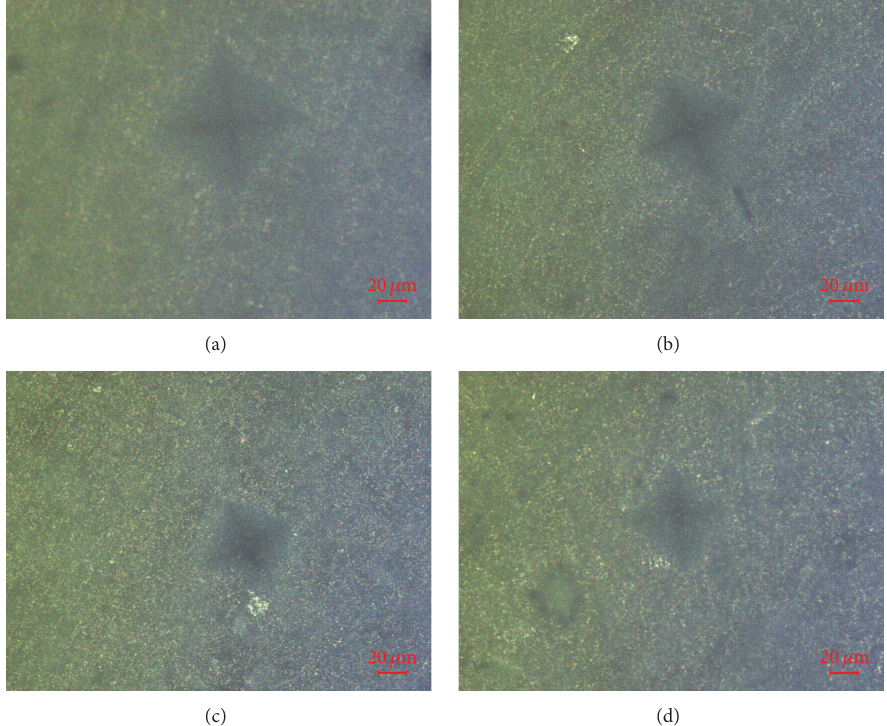
Figure 5: Optical microscope of the ZrO 2 ceramics with addition of (a) 0, (b) 1, (c) 3, and (d) 5wt% TiO 2 contents (the scale bar is 20 𝜇